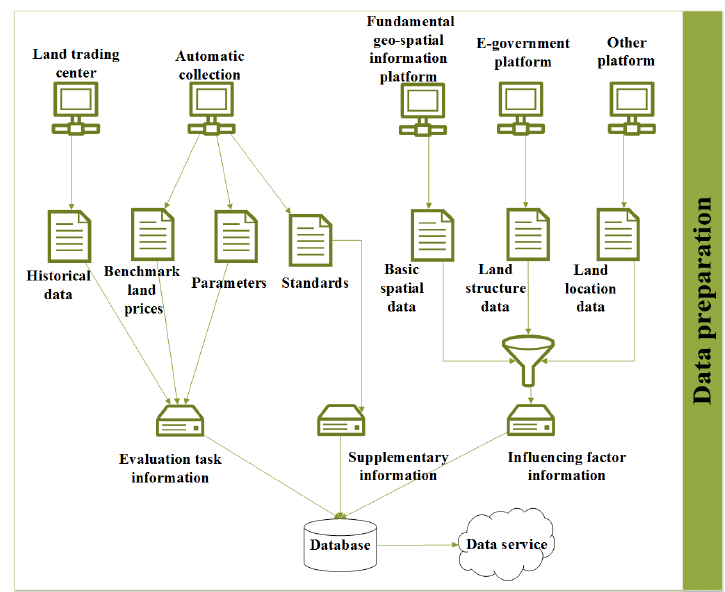
Figure 1. Data preparation procedure.